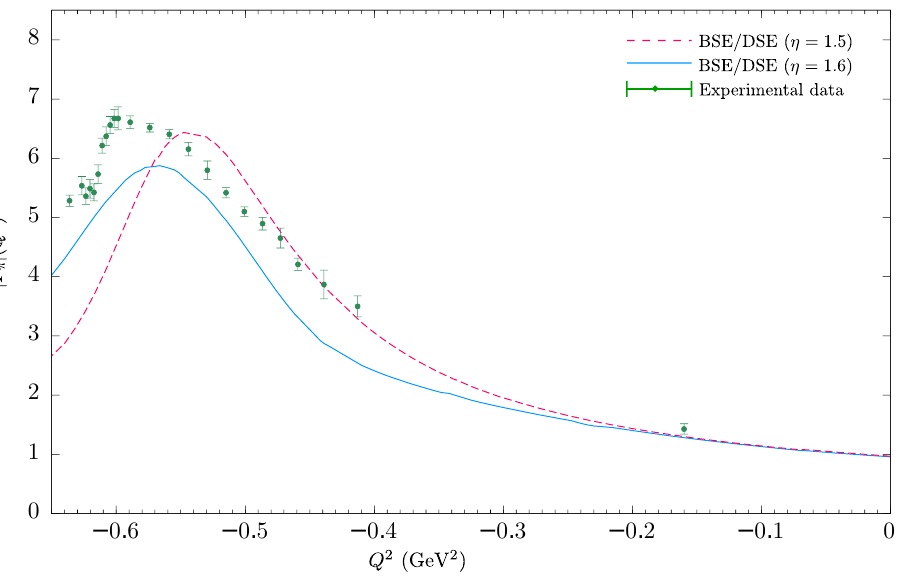
Table 2. The coe ffi cients of the rational fits to the pion form factor as discussed in the text. All values for dimensionful quantities are given in